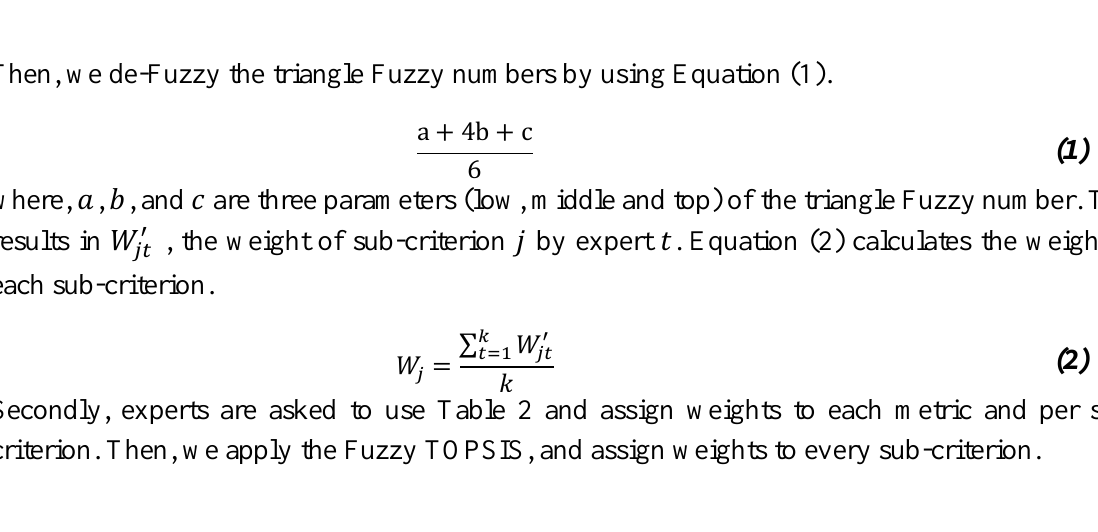
Table 2. Linguistic variables and fuzzy rating